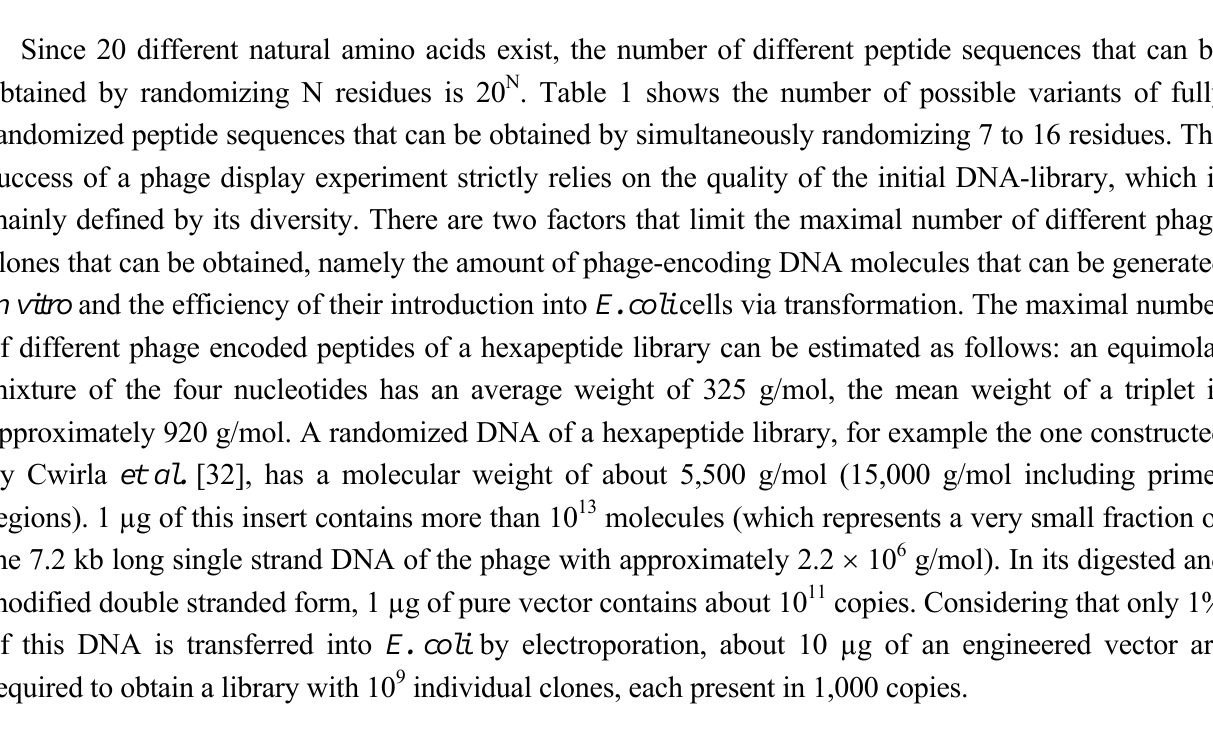
Table 1 . Correlation between the number of random amino acids and the maximal diversity of a peptide